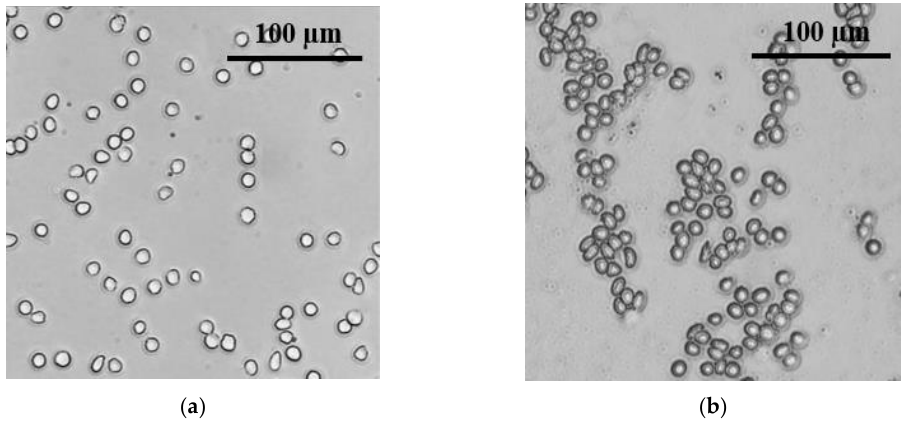
Figure 7. ( a ) Effect of cationic liposomes IA-16/PC (surfactant/lipid molar ratio of 0.029/1) on agglutination of erythrocytes was observed by fluorescent microscopy in phase contrast mode in liposome solutions with the highest lipid concentration; ( b ) in mixture of type A (II) and B (III) erythrocytes — positive agglutination control.